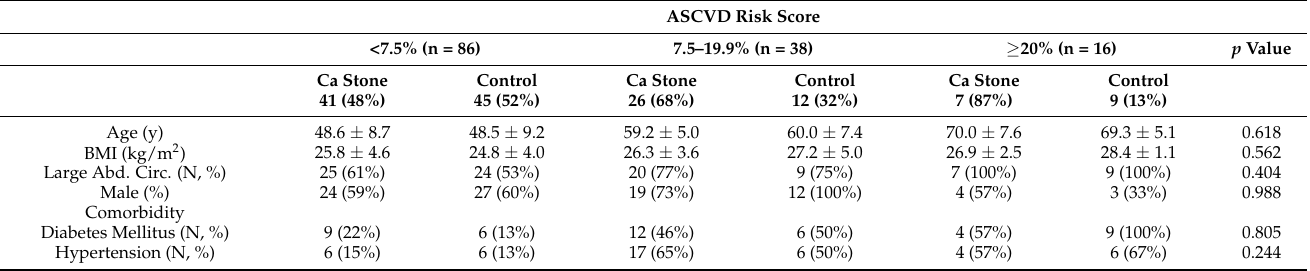
Table 2. Comparison of basic data, 24 h urinary biochemistry, and pre-treatment serum inflammation markers between patients with and without calcium-containing stone in different ASCVD risk score. Data presented as mean ±